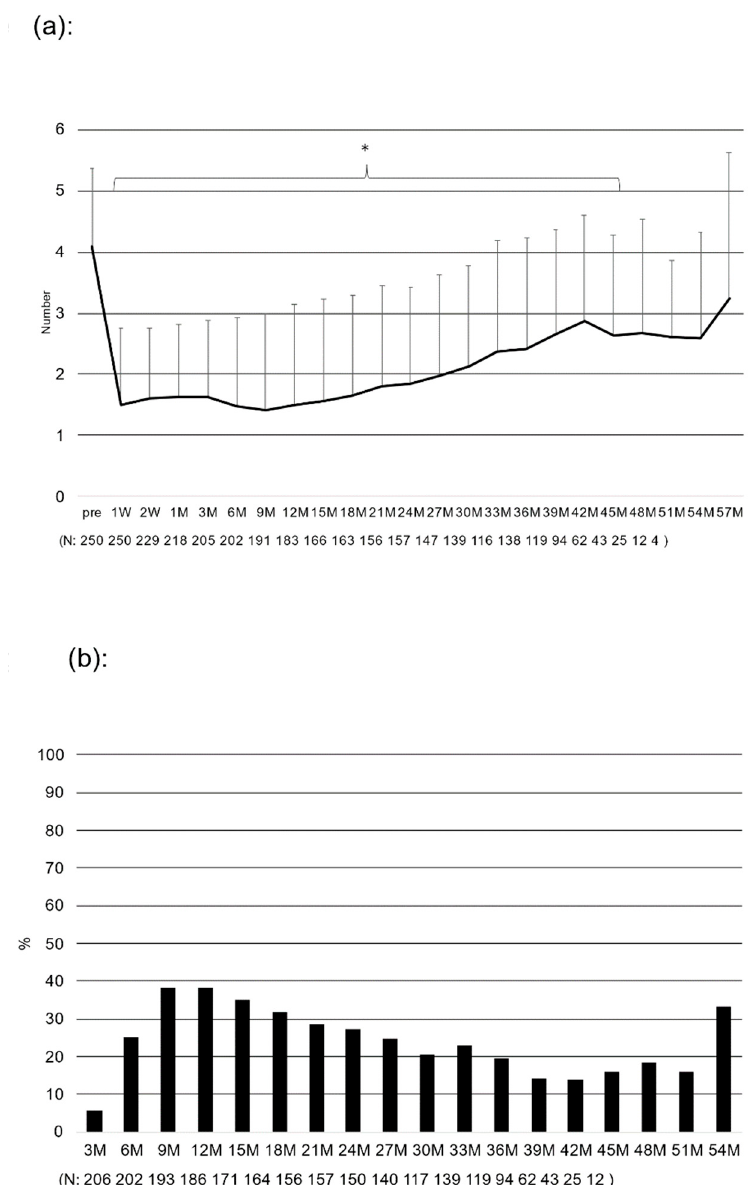
Figure 2 . Postoperative changes in the number of antiglaucoma medications and the rate of medication-free eyes: ( a ) postoperative reduction in the number of antiglaucoma medications, * p < 0.001 vs. preoperative value (repeated ANOVA), ( b ) postoperative rates of medication-free eyes. Bar = SD.